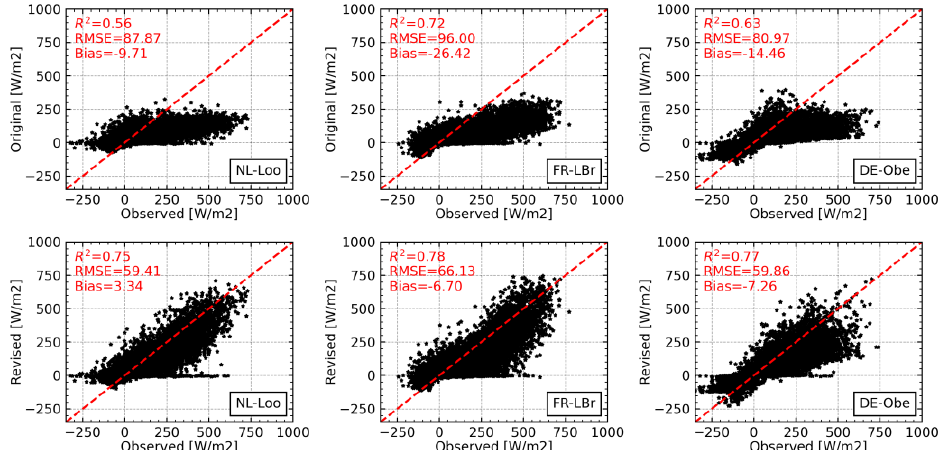
Figure 11. Relationship between the observed and simulated sensible heat flux by the original and the revised parameterization at Evergreen Needle leaf Forest (ENF) sites. the revised parameterization at Evergreen Needle leaf Forest (ENF) sites.